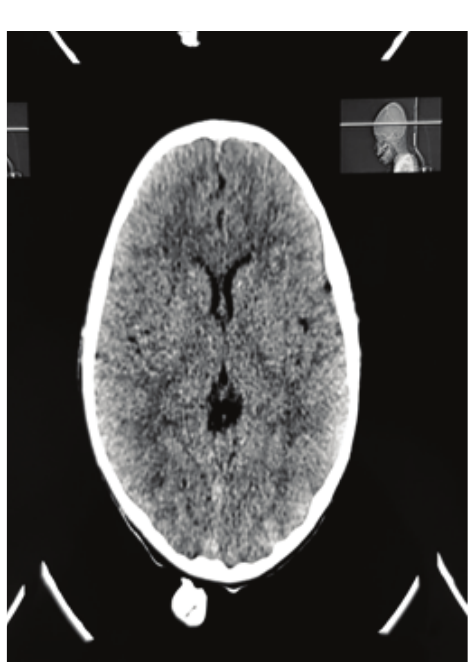
Figure 2 : Brain CT scan of the patient showing normal basal ganglia (white arrow).